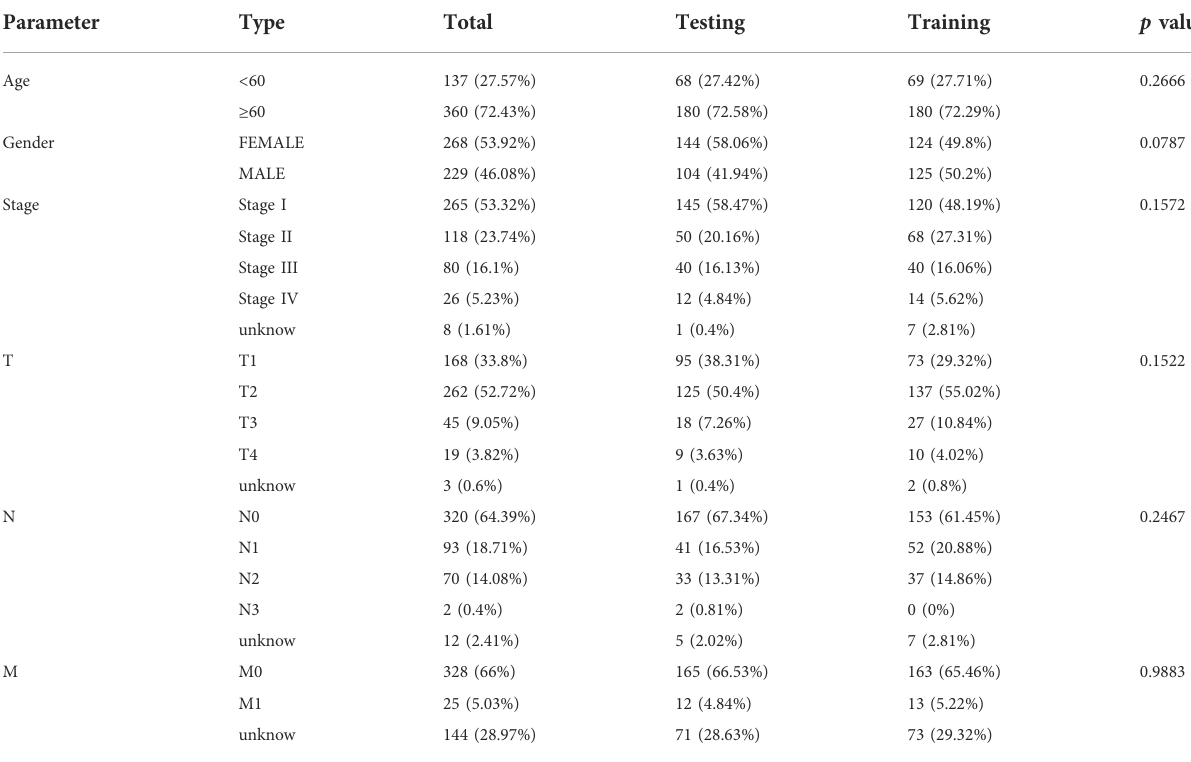
TABLE 2 Comparison of clinical characteristics. (Chi-squared